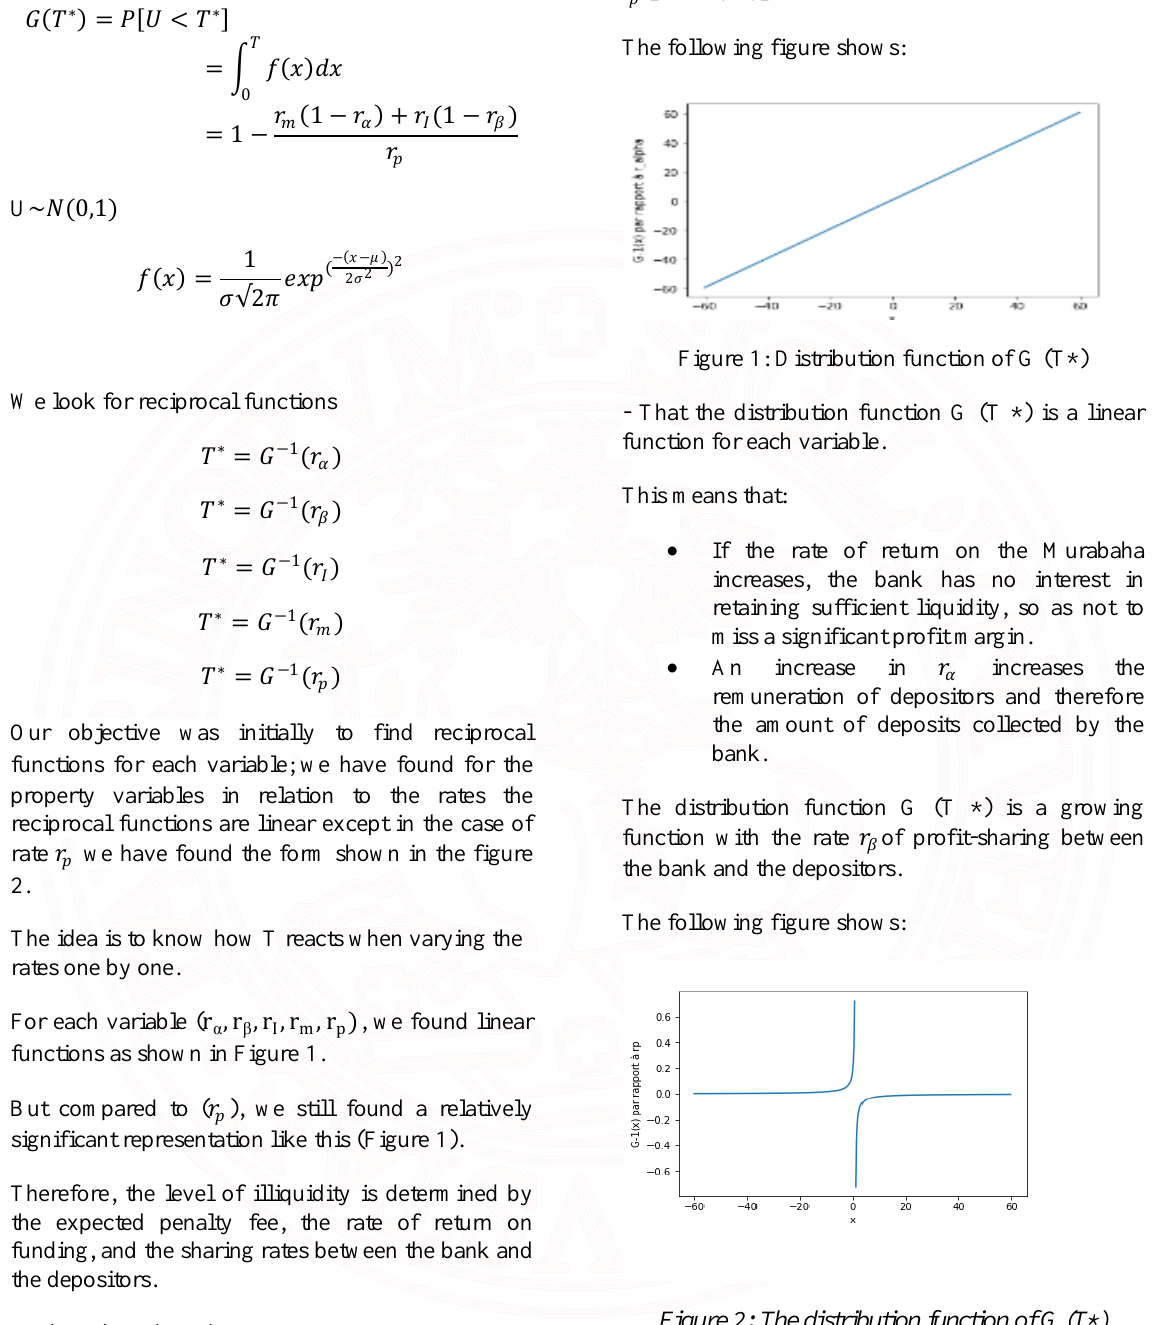
Figure 2: The distribution function of G